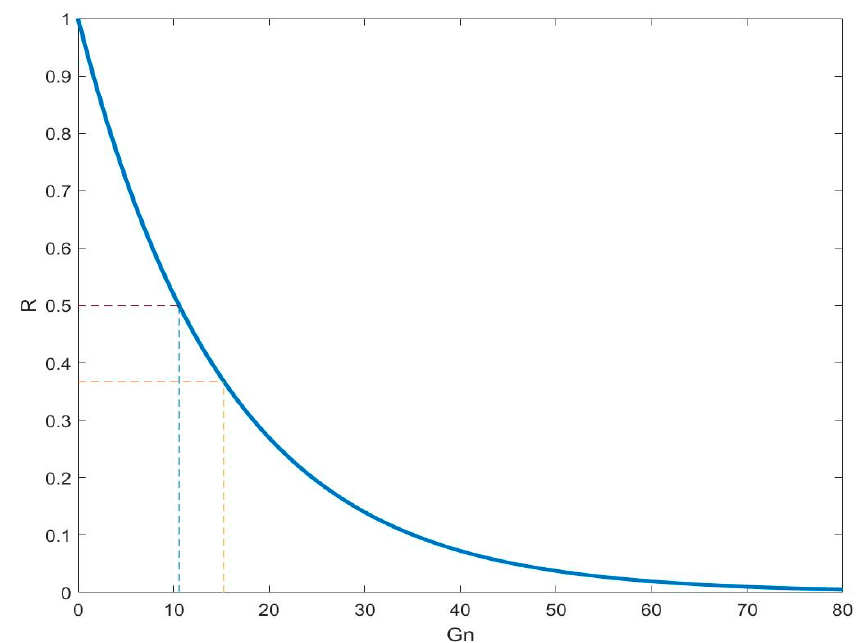
Figure 4 . Reliability curve of exponential distribution. Figure 4. Reliability curve of exponential